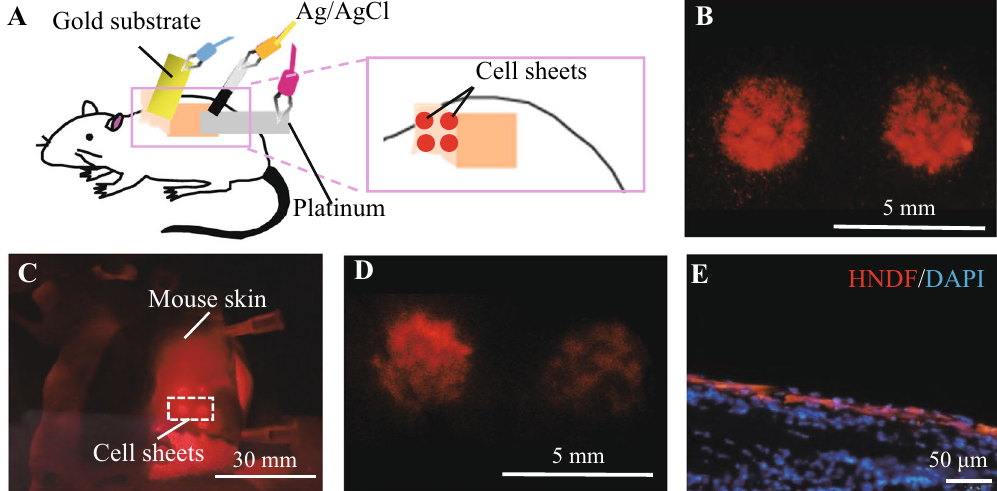
Figure 4. Electrochemical cell sheet transplantation to mice. ( A ) Schematics. ( B , C ) Patterned cell sheets on the flat gold substrate modified with oligopeptides ( B ) were transplanted on the subcutaneous pocket ( C ). ( D ) Magnified view of the square region in ( C ). ( E ) Skin at the transplanted site was sectioned and counter-stained with